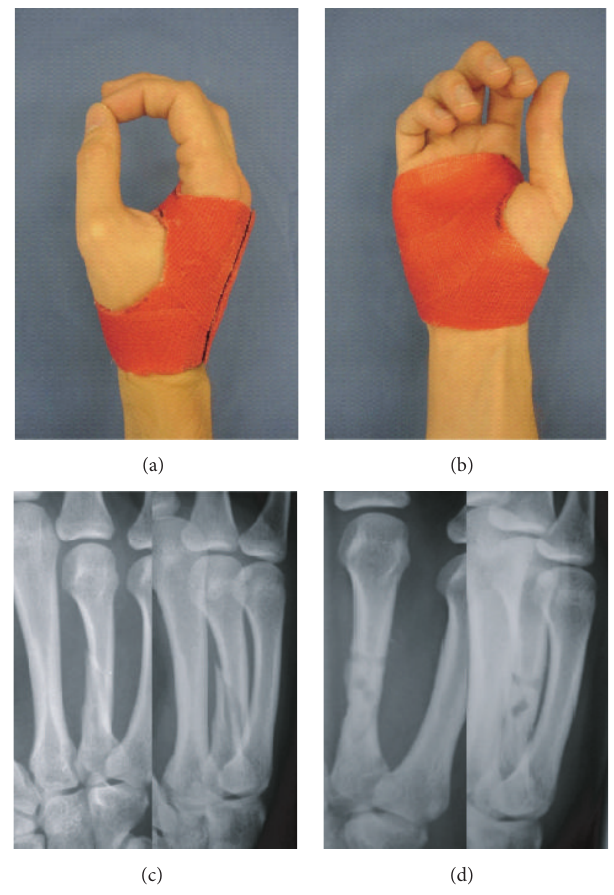
Figure 3: Middlehand orthoses (fingers excluded): (a) dorsoradial and (b) palmar view; case sample: displaced 4th metacarpal fracture, (c) X-ray on admission and (d) at 6 weeks following open reduction and fixation (resorbable implant; 2 mm LactoSorb® plate) (DASH analysis of case series: 𝑛 = 15 ; score-mean = 32.07 ± 3.54 SD; DASH follow-up interval (weeks): 11.57 ± 0.77 SD).